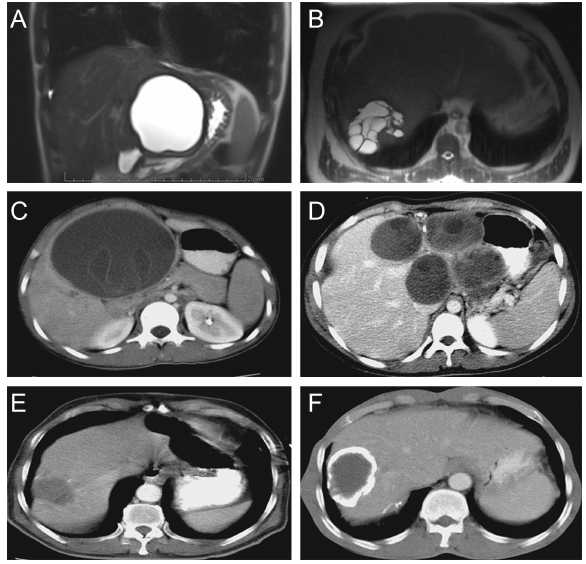
Figure 1. A-F. Demonstration of differential diagnosis of cystic echinococcosis by computed tomography (CT) and magnetic resonance imaging (MRI) according to the cyst stage. (A) Hyperintense hepatic cyst with double-line sign considered pathognomonic for World Health Organization (WHO) CE1 cysts, T2-weighted MRI. (B) Multivesicular cystic echinococcosis hepatic cyst WHO CE2 cyst, T2-weighted MRI. (C) Hypodens hepatic cyst with detached endocyst (water-lily sign) WHO CE3A cyst, CT. (D) Daughter cysts inside a solid cyst matrix WHO CE3B cyst, CT. (E) Heterogeneous, parasitic membranes embedded in avascular solid contents WHO CE4 cyst, CT. (F) Cysts with degenerative content and heavily calcified wall WHO CE5 cyst,